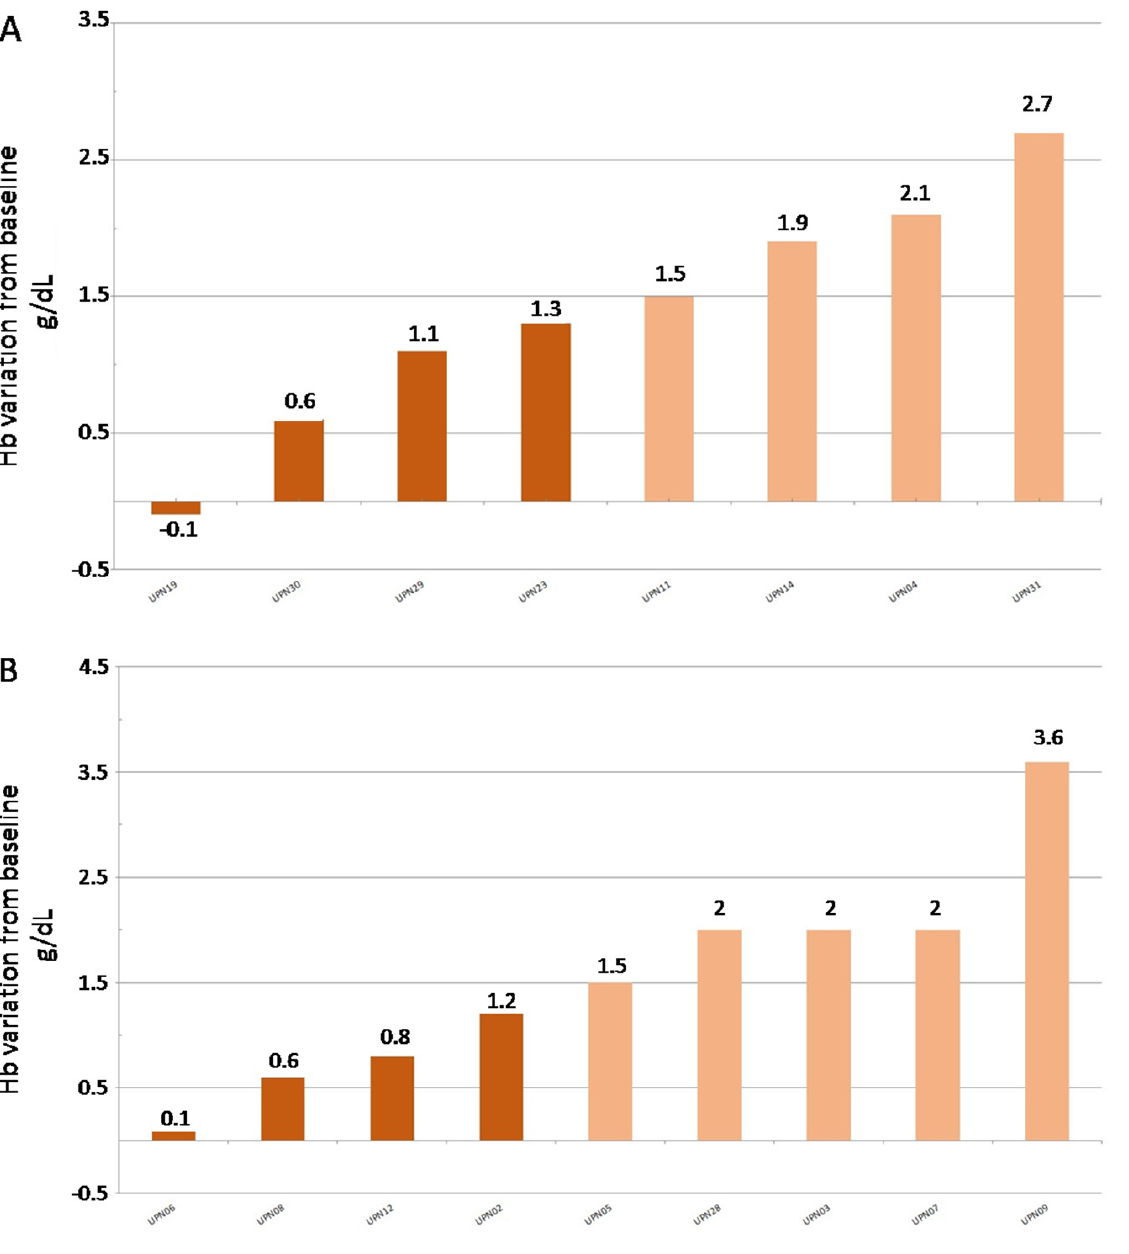
Figure 2. Waterfall plot indicating the Hb augmentation. ( A ) patients pursuing with 40,000 U of EPO-zeta per week; ( B ) patients doubling the dosage of EPO-zeta to 80,000 U per week. Overall, 27 responses (75%) were evaluable after 16 weeks of evaluation. Figure 3 shows the response to the ESA according to disease characteristics. According to the study design, the study’s primary endpoint was